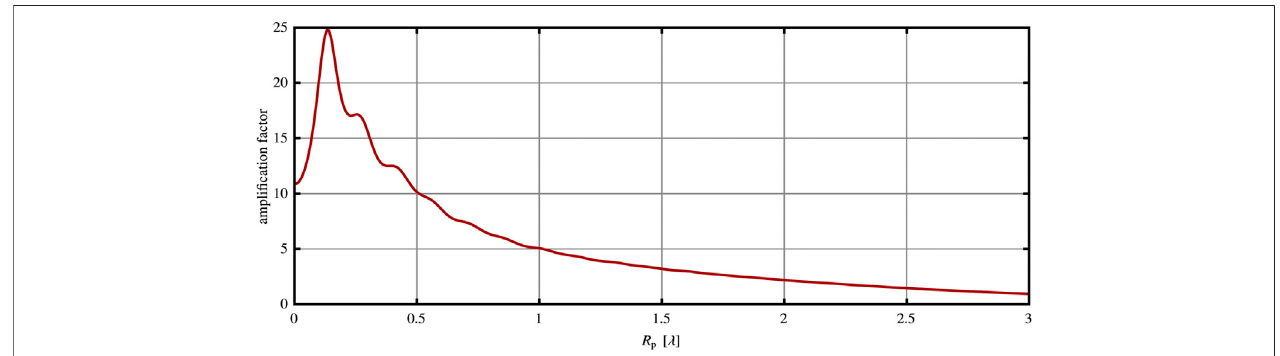
FIGURE8| Dependenceofampli fi cationfactoroftheplasmonicnanojet/hotspotonaparticlesize.TheincidentwaveisaradialGaussianbeam(LG 0,rad ). ϵ p / ϵ med (cid:2) − 22.5 + 1.4 i , f (cid:2) 0.3, and z (cid:2) 0.75 R b p